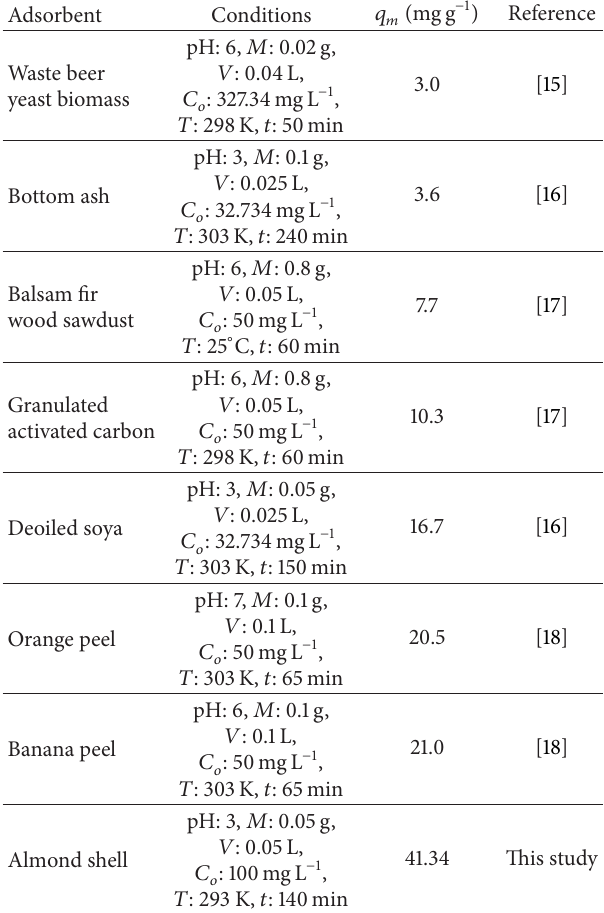
Table 4: Comparison of methyl orange adsorption capacity of various